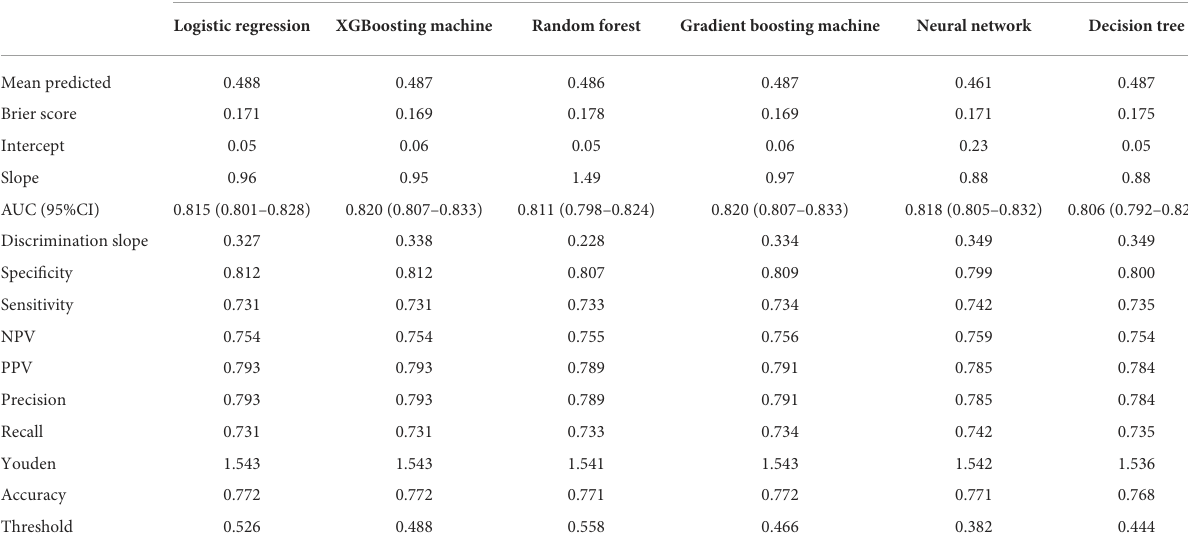
TABLE 3 Prediction performance of machine learning algorithms for the estimation of 3 month mortality among bone metastasis patients with lung cancer.